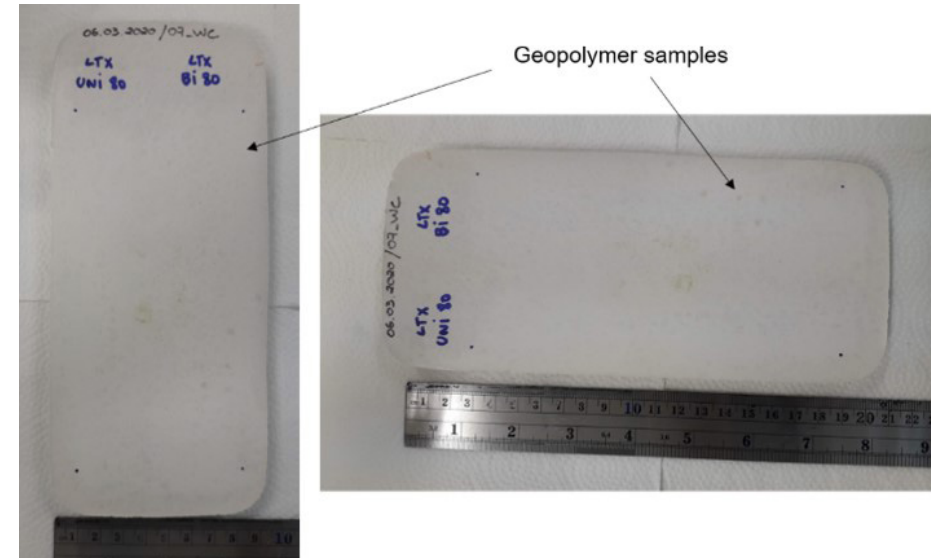
Figure 2. Geopolymer samples for pull off